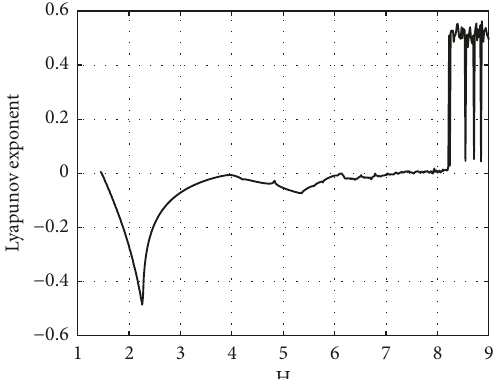
Figure 10: Values of Lyapunov exponent 𝐿 of orbits generated by (28). Parameters: (𝐹,𝐺) = (43,5) and 1.43 < 𝐻 < 9